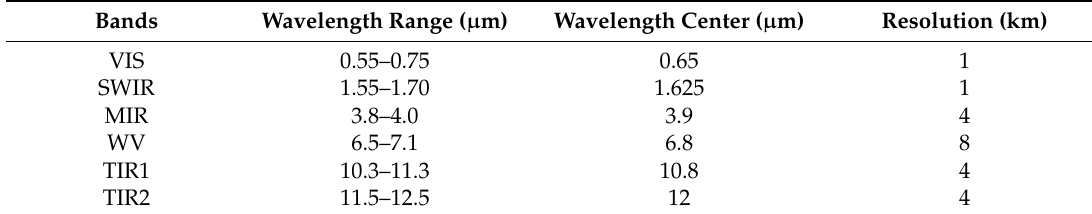
Table 1. INSAT-3D Imager bands.